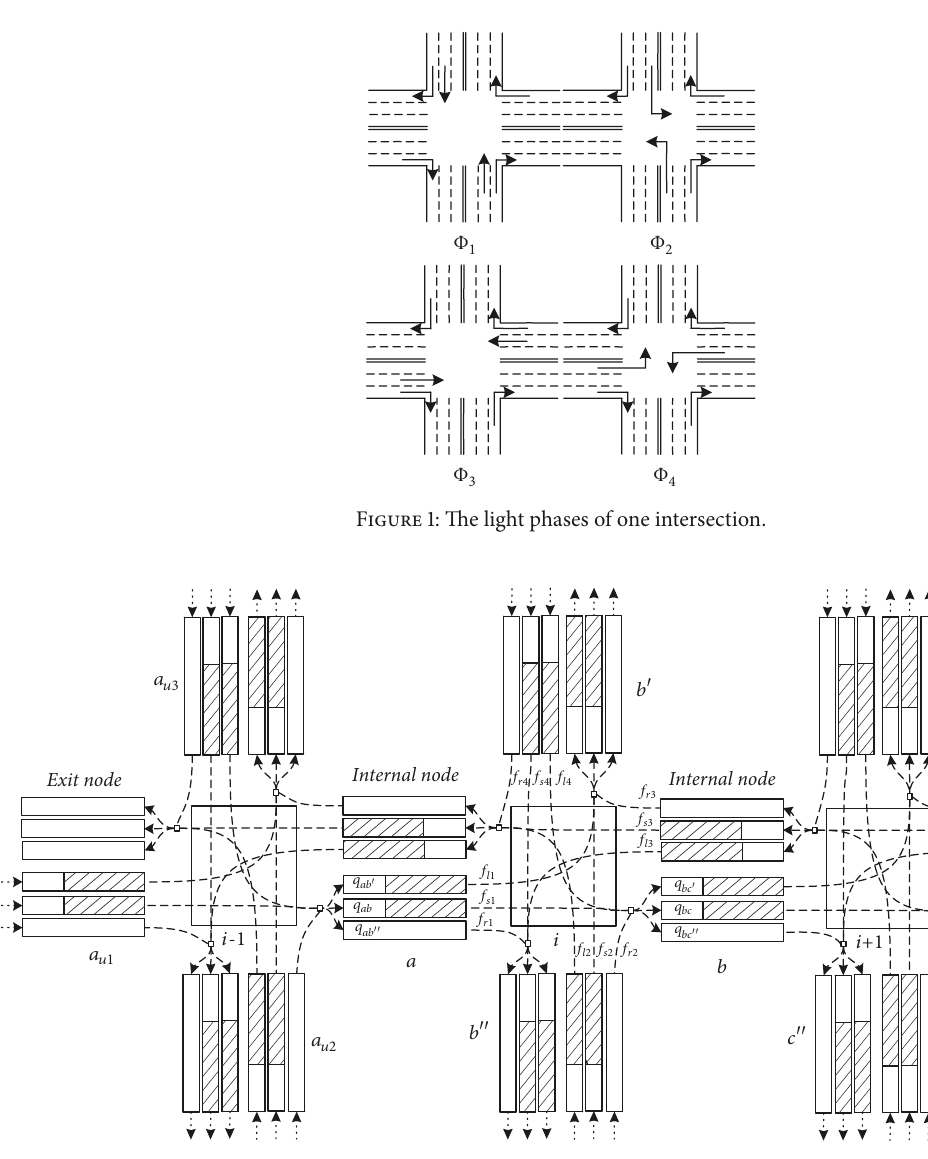
Figure 2: The topology of queuing traffic